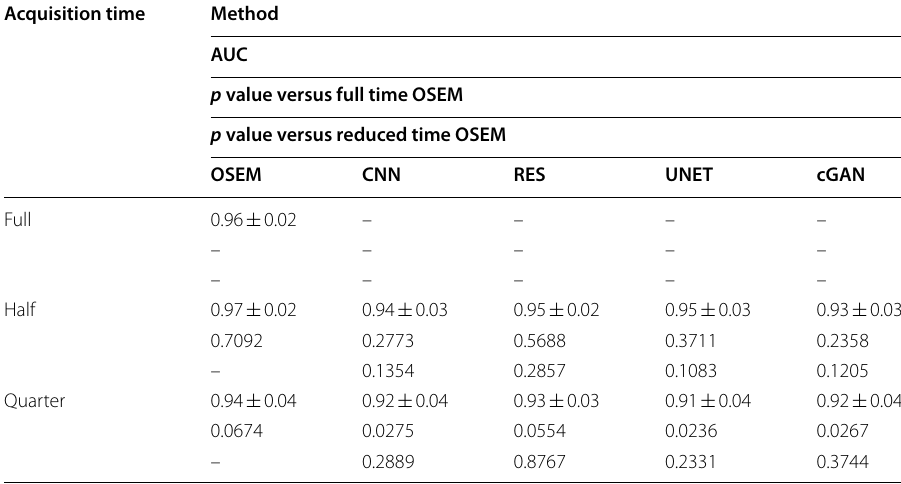
Table 6 Area under the ROC curve (AUC acquisition times at